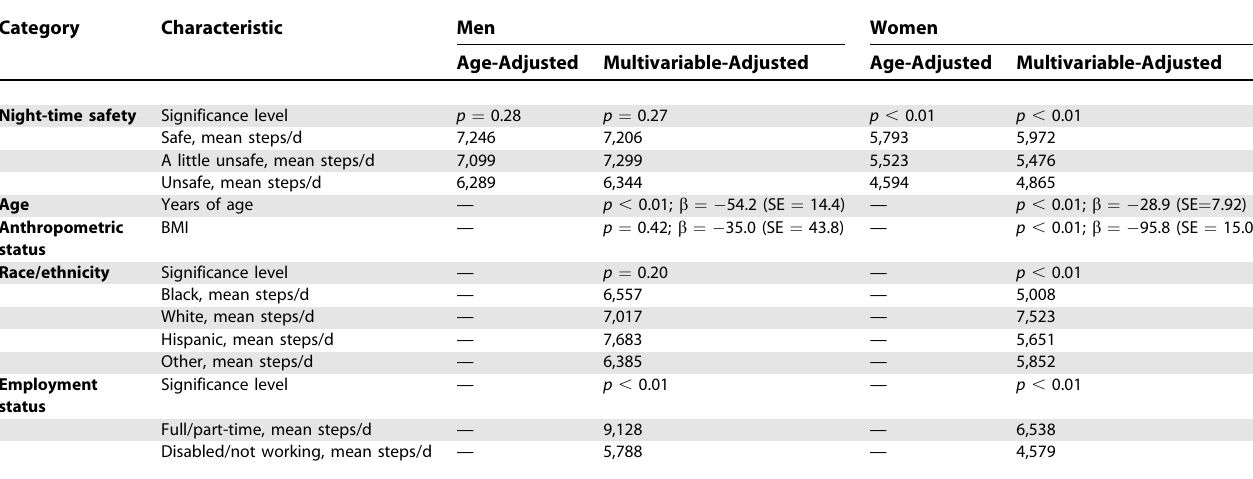
Table 2. Perceived Night-time Neighborhood Safety and Steps Per Day